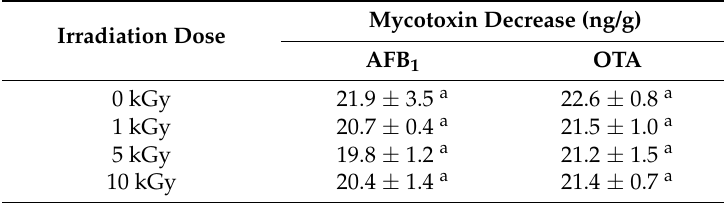
Table 5. Reduction (ng/g; mean ± SD; n = 6) of aflatoxin B1 and ochratoxin A in spiked dried samples (30 ng/g of each mycotoxin) of Aloysia citrodora submitted to irradiation treatments at 1, 5, and 10 kGy, in comparison with non-irradiated samples (0